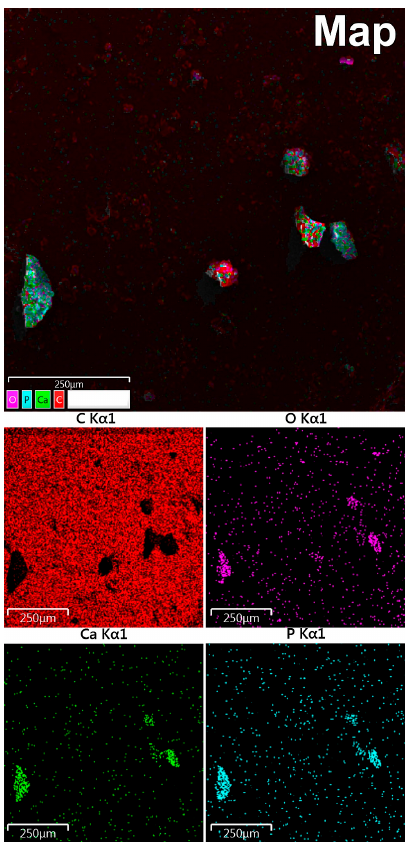
Figure 3. Study of OC calcification by EDX mapping: red indicates carbon, purple—oxygen, green— calcium, blue—phosphorus.